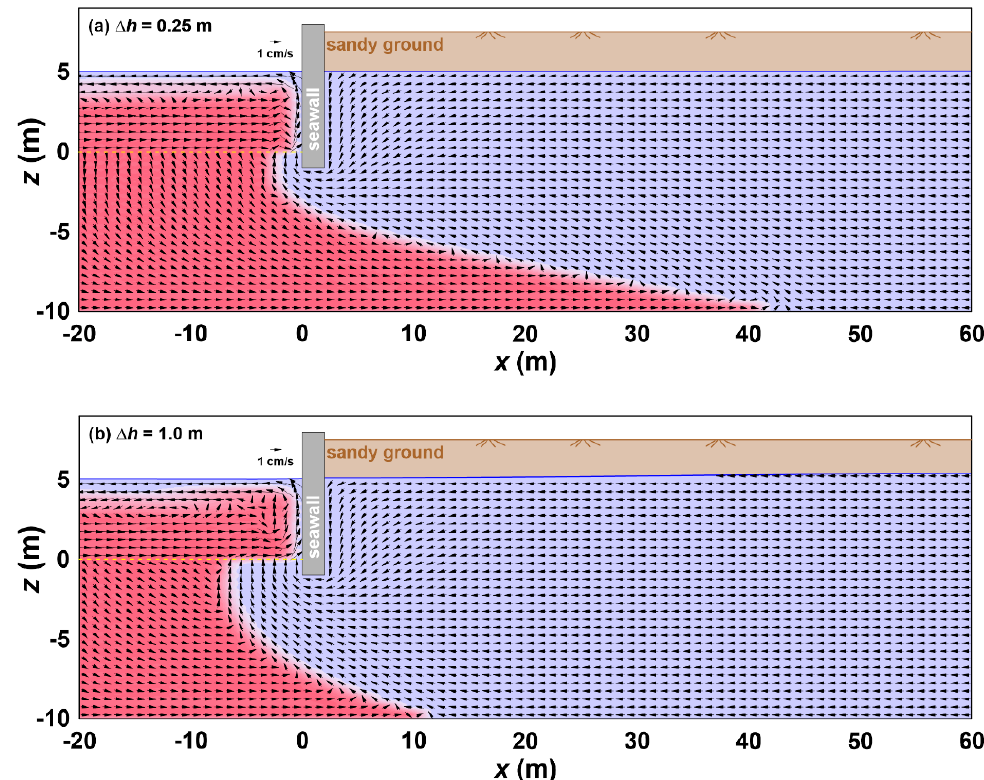
Figure 11. Characteristics of groundwater flow due to seawater–freshwater differences in water levels. ( a ) Δ h = 0.25 m, the smallest value, and ( b ) Δ h = 1 m.